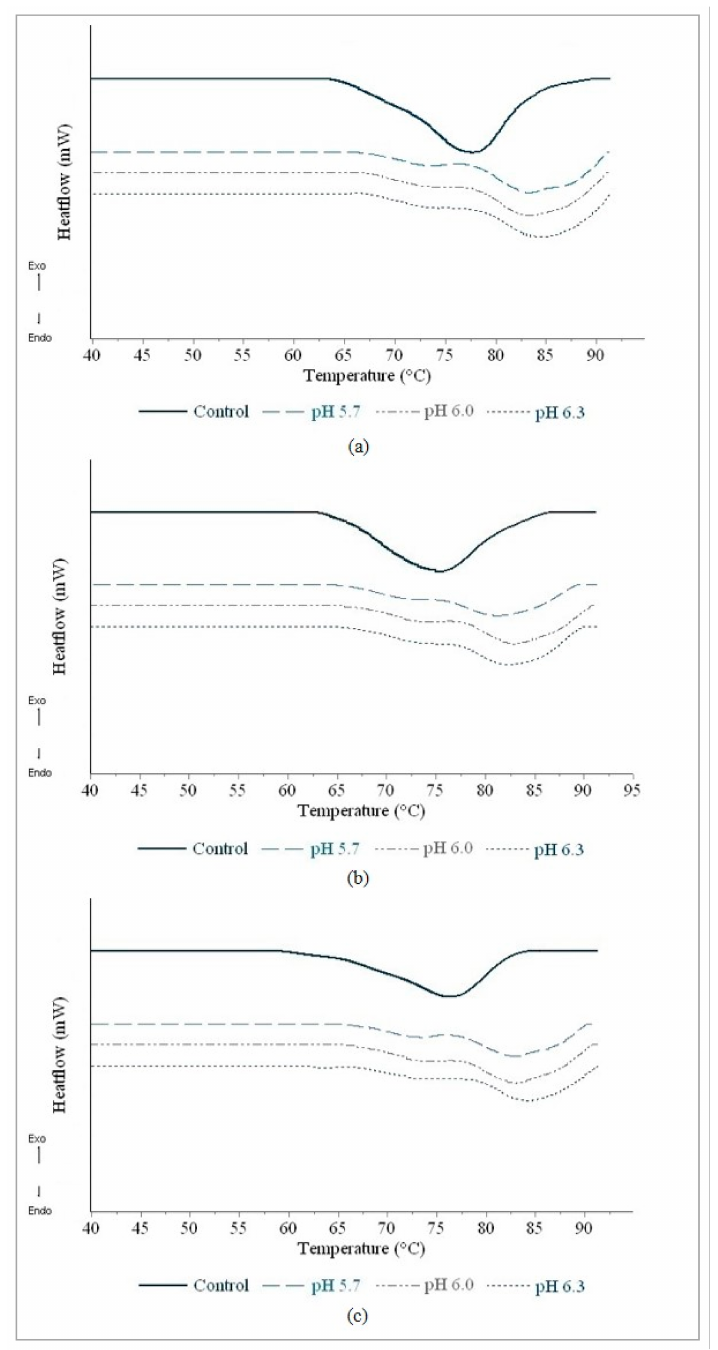
Figure 6. Differential scanning calorimetry thermograms of liquid egg yolk samples before freezing ( a ), and frozen-thawed after 14 days ( b ) and 28 days ( c ) of storage at − 18 ◦